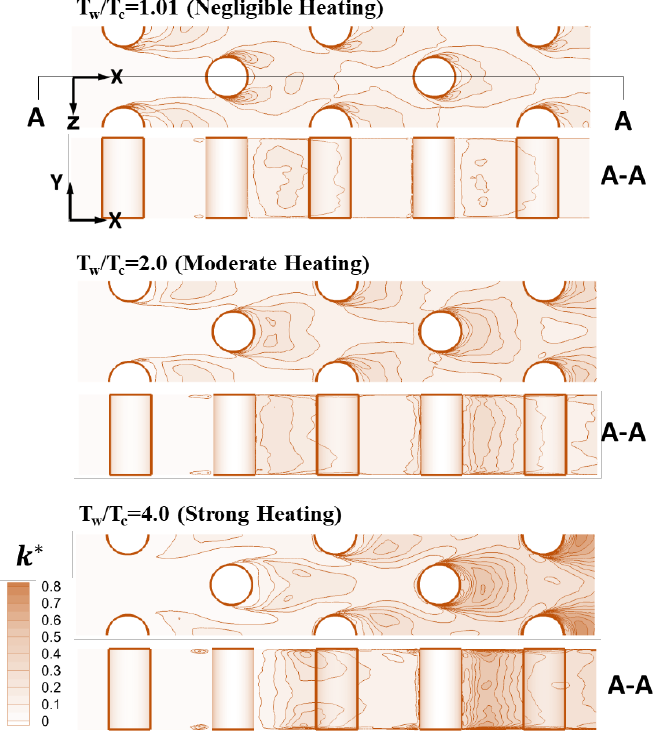
Figure 16. Total turbulent kinetic energy distribution for various wall heating levels.